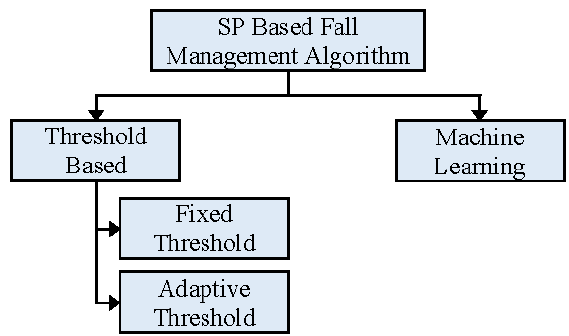
Figure 3. Taxonomy of smartphone based fall detection and prevention